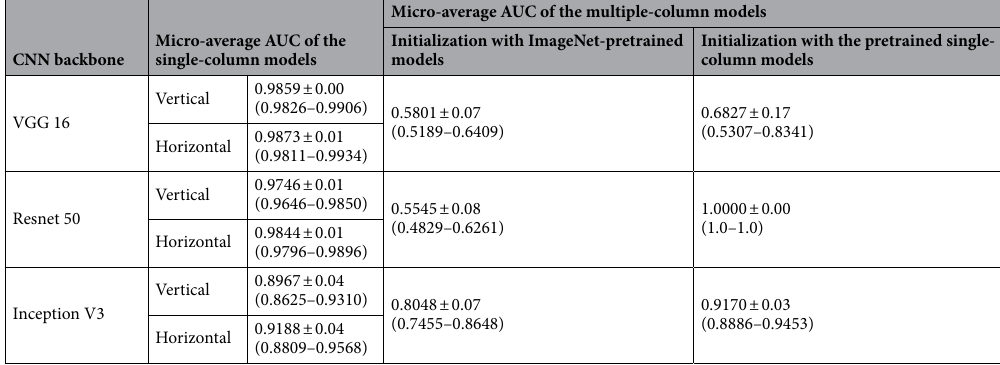
Table 2. Five-fold cross validation results for each of the single- and multiple-column models. CNN convolutional neural network, AUC area under the receiver operating characteristic curve. Data are mean ± standard deviation (95% confidence interval).